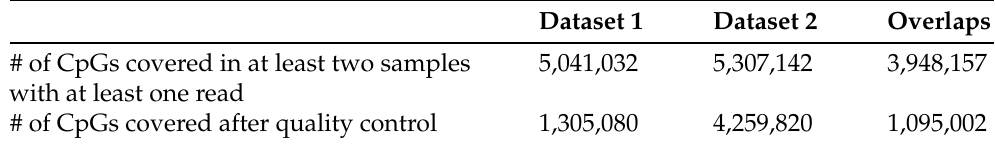
Table 2. Number of CpGs covered in the two datasets, and overlaps in captured sites.